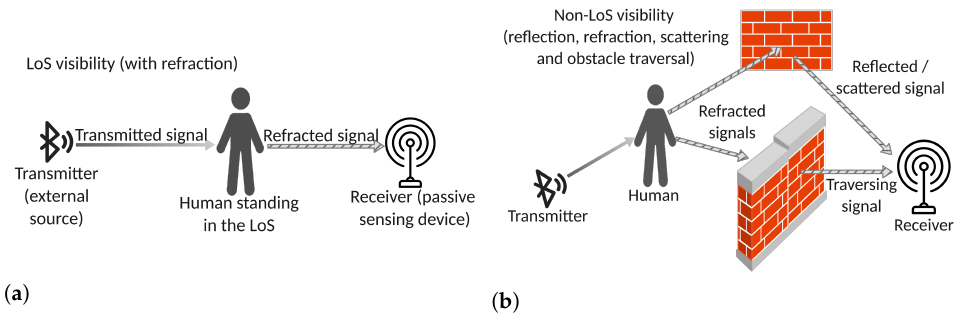
Figure 1. Line of Sight (LoS) visibility ( a ). Non-Line of Sight and through-the-wall ( b